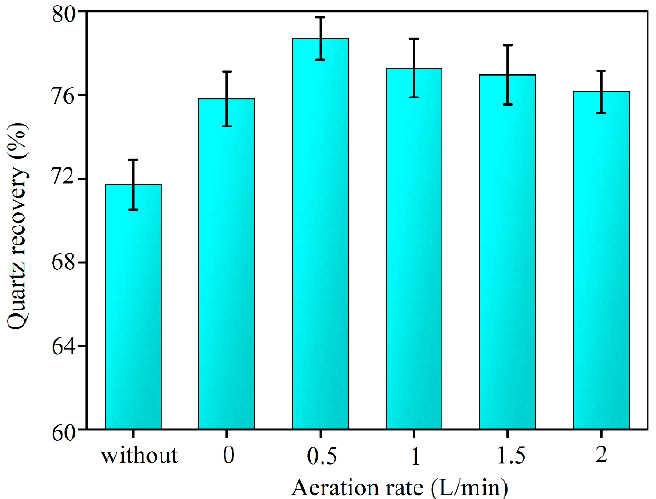
Figure 12. Effect of BMNBs water prepared by different aeration rates on flotation recovery (preparation time 2 min).